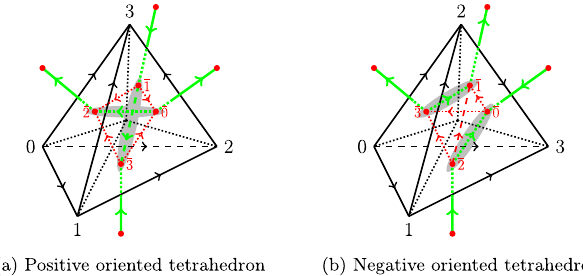
FIG. 19. Resolvation of four strings of Kitaev ’ s Majorana chains meeting at one tetrahedron. If four strings meet at one tetrahedron, we should pair the Majorana fermions ¯3 , respectively (gray ellipses). The green lines on these lines are decorated by Kitaev